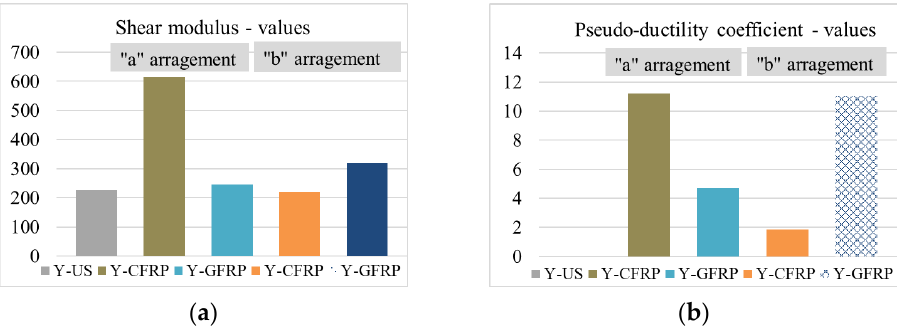
Figure 14. Comparison of significant values for all tested series in a range of: ( a ) shear modulus; ( b ) pseudo-ductile coefficient.